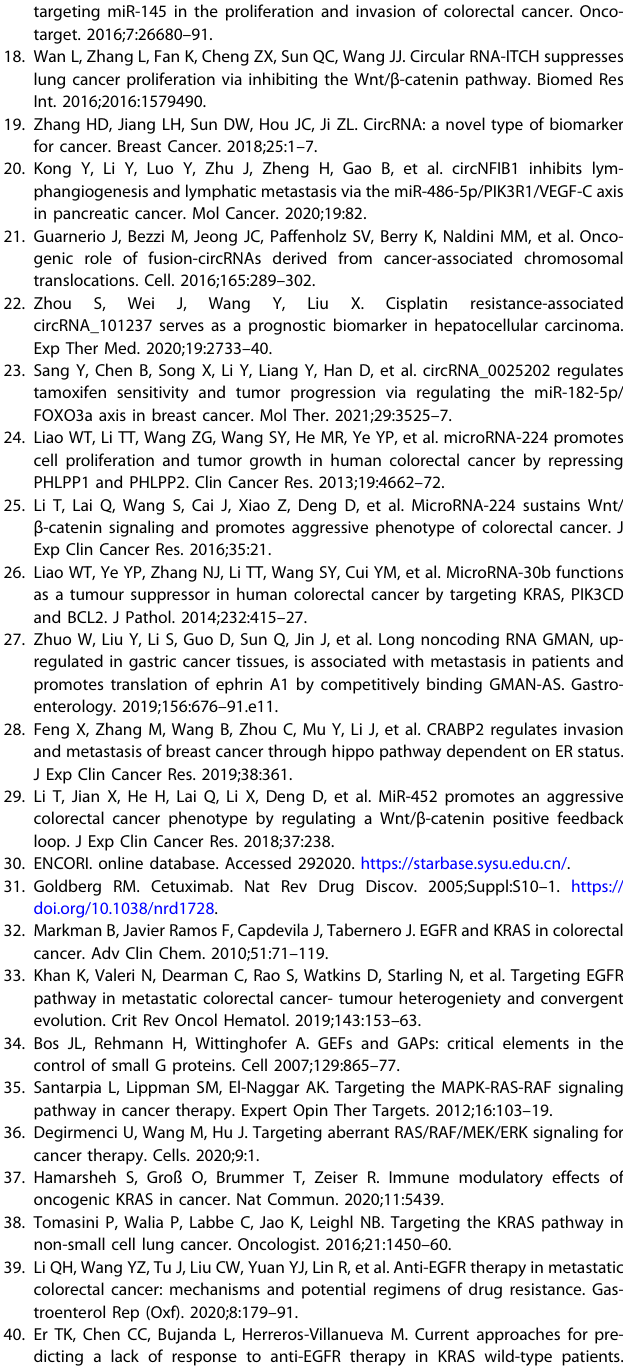
Fig. 6 Overexpression of circIFNGR2 lowers the sensitivity of CRC cells to cetuximab. HCT8 and CACO2 cells were divided into four groups, which were respectively treated with vector + DMSO, vector + Cetuximab, circIFNGR2 + DMSO or circIFNGR2 + Cetuximab. a CCK8 assay revealed the cell growth ability of the indicated cells. b The transwell chamber assay detected the migration ability of the indicated cells. c Plate colony formation assay con fi rmed the proliferation ability of the indicated cells. Representative images(left); Statistical analysis of experimental